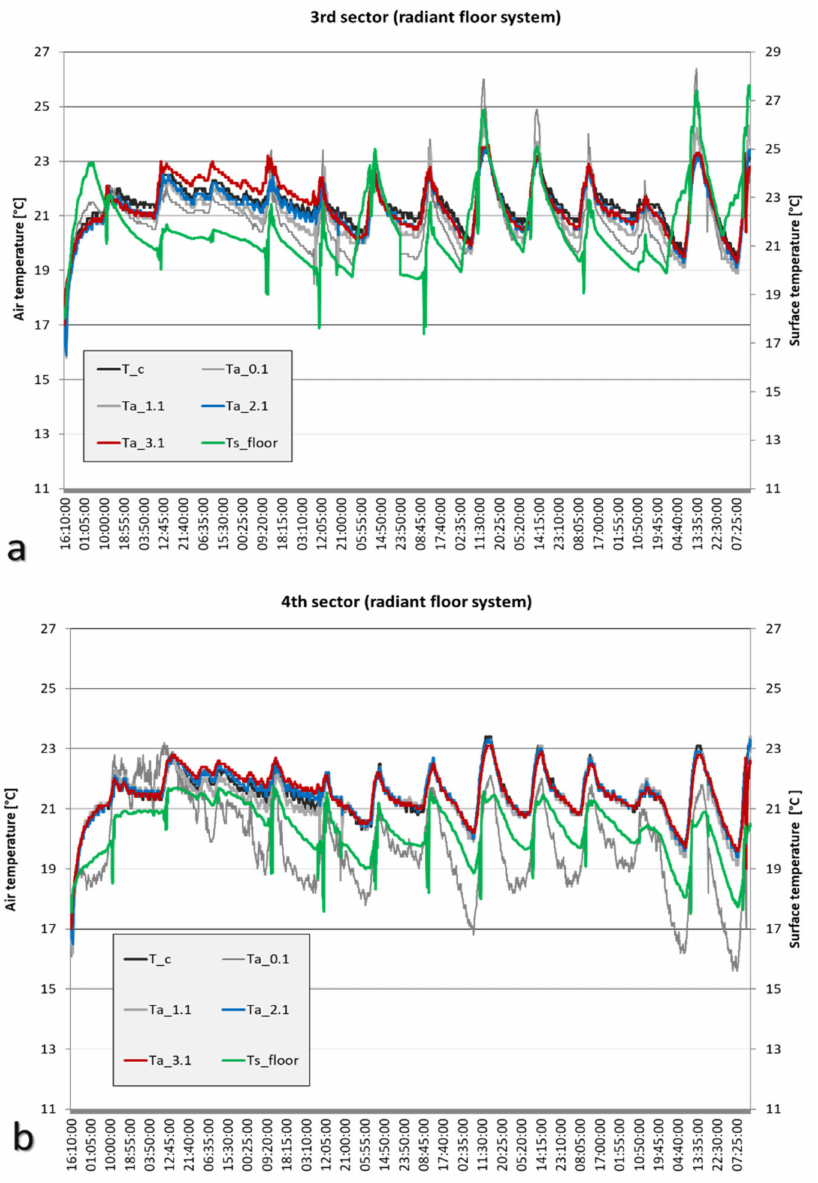
Figure 12. Air temperature at different heights with radiant floor system: ( a ) 3rd sector, ( b ) 4th